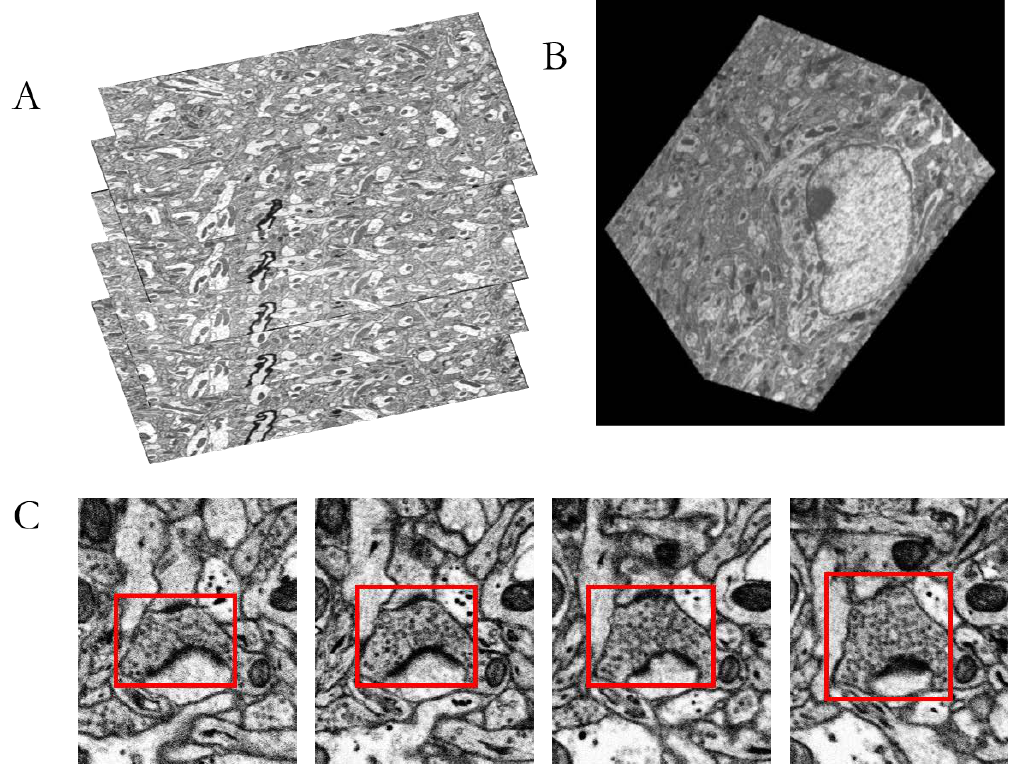
Figure 1. Datasets and multisynaptic boutons (MSBs). ( A ) Serial SEM images; ( B ) an anisotropic stack of neural tissue from mouse cortex acquired by Automated tape-collecting ultra-microtomy (ATUM)-SEM; ( C ) MSBs appearing on serial images.